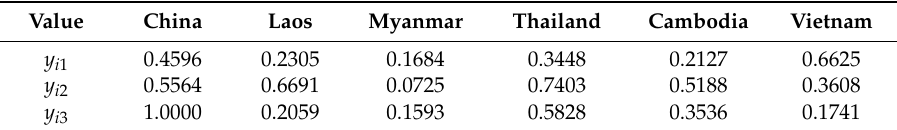
Table 4. Composite index value of each